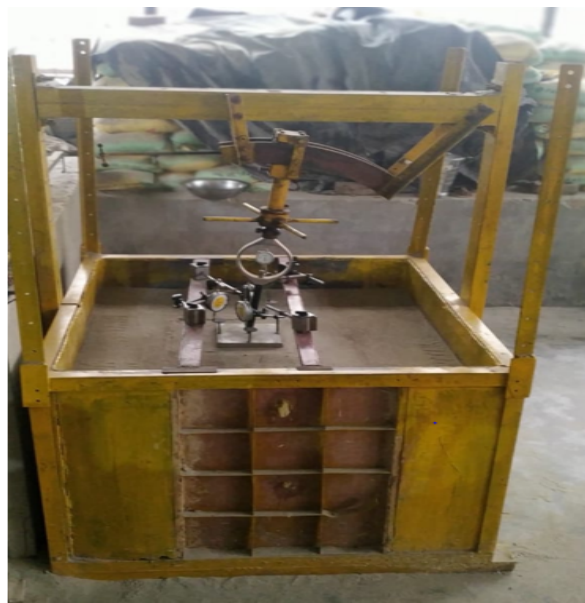
Figure 5: Experimental set up for 5° angle of